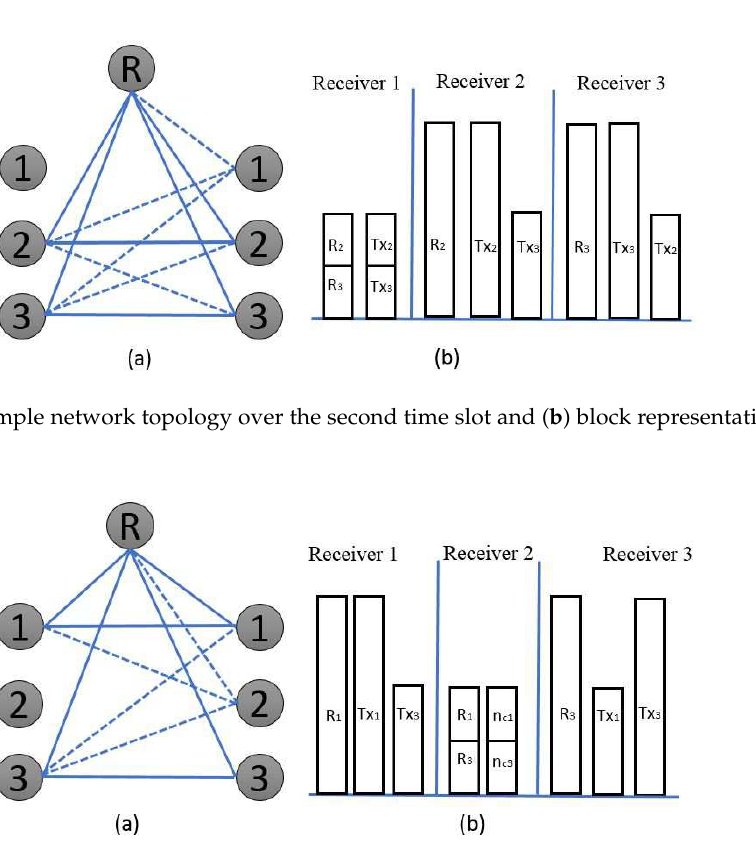
Figure 4. ( a ) simple network topology over the first time slot and ( b ) block representation of the received signal.